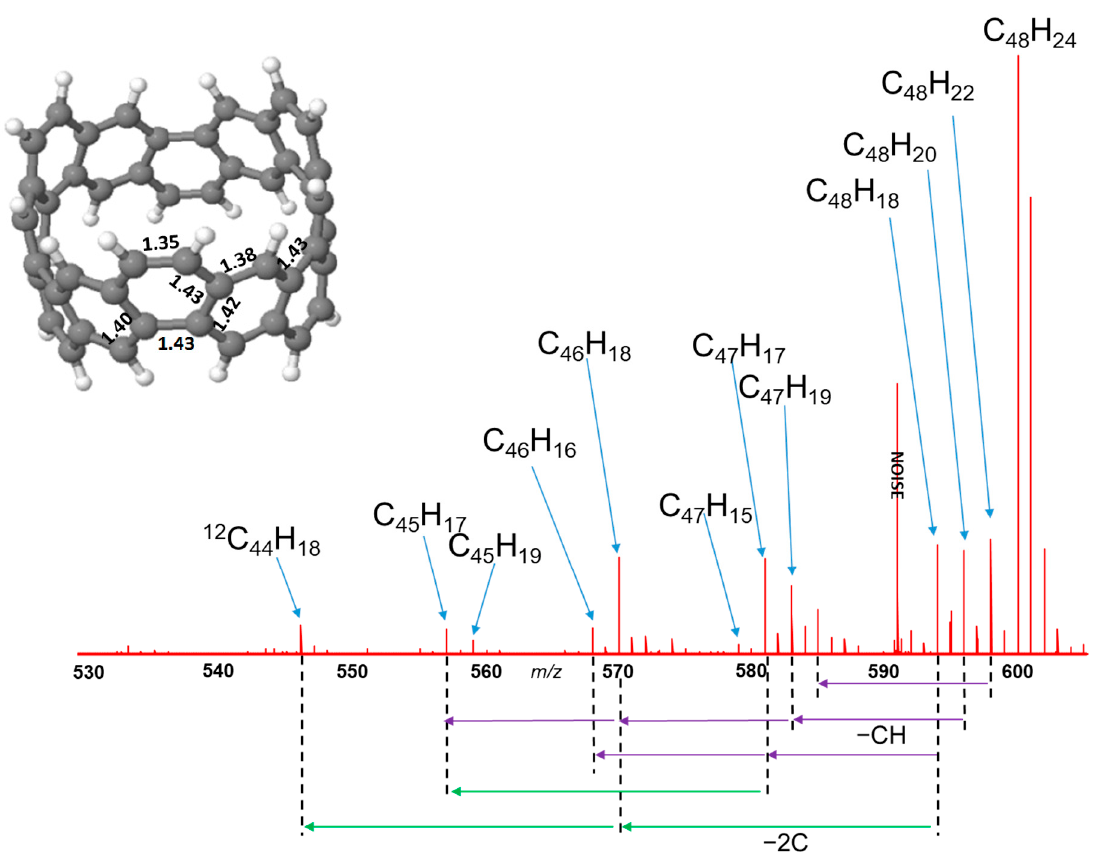
Figure 1. FT-ICR mass spectrum of C 48 H 24 nanobelts showing dissociation through loss of varying quantities of H 2 , (CH) + H 2 and (C 2 ) + H 2 . X -axis indicates m/z ratio for positive ion species. Inset shows the DFT-optimised nanoring structure in + 1 charge state, calculated bond lengths marked in Angstroms.